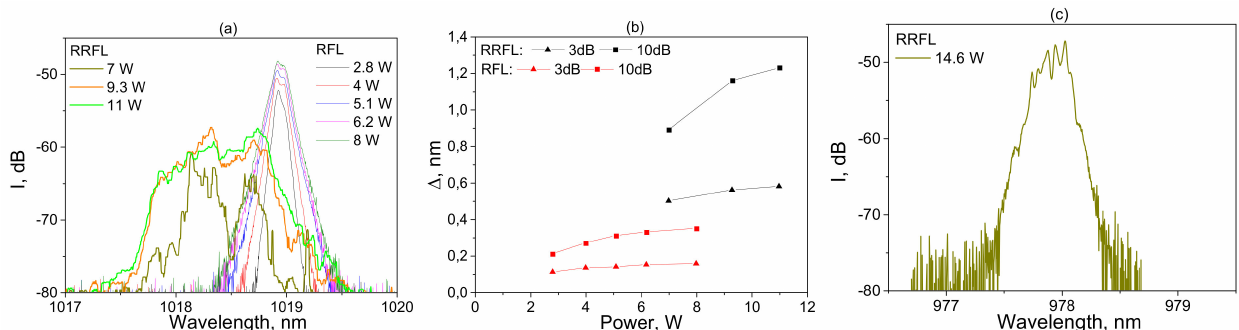
Figure 6. Comparison of spectral shapes ( a ) and linewidths ( b ) at − 3 dB and − 10 dB levels for RFL and RRFL 2nd Stokes generation at 1019 nm. ( c ) Spectral shape of RRFL 2nd Stokes generation at 978